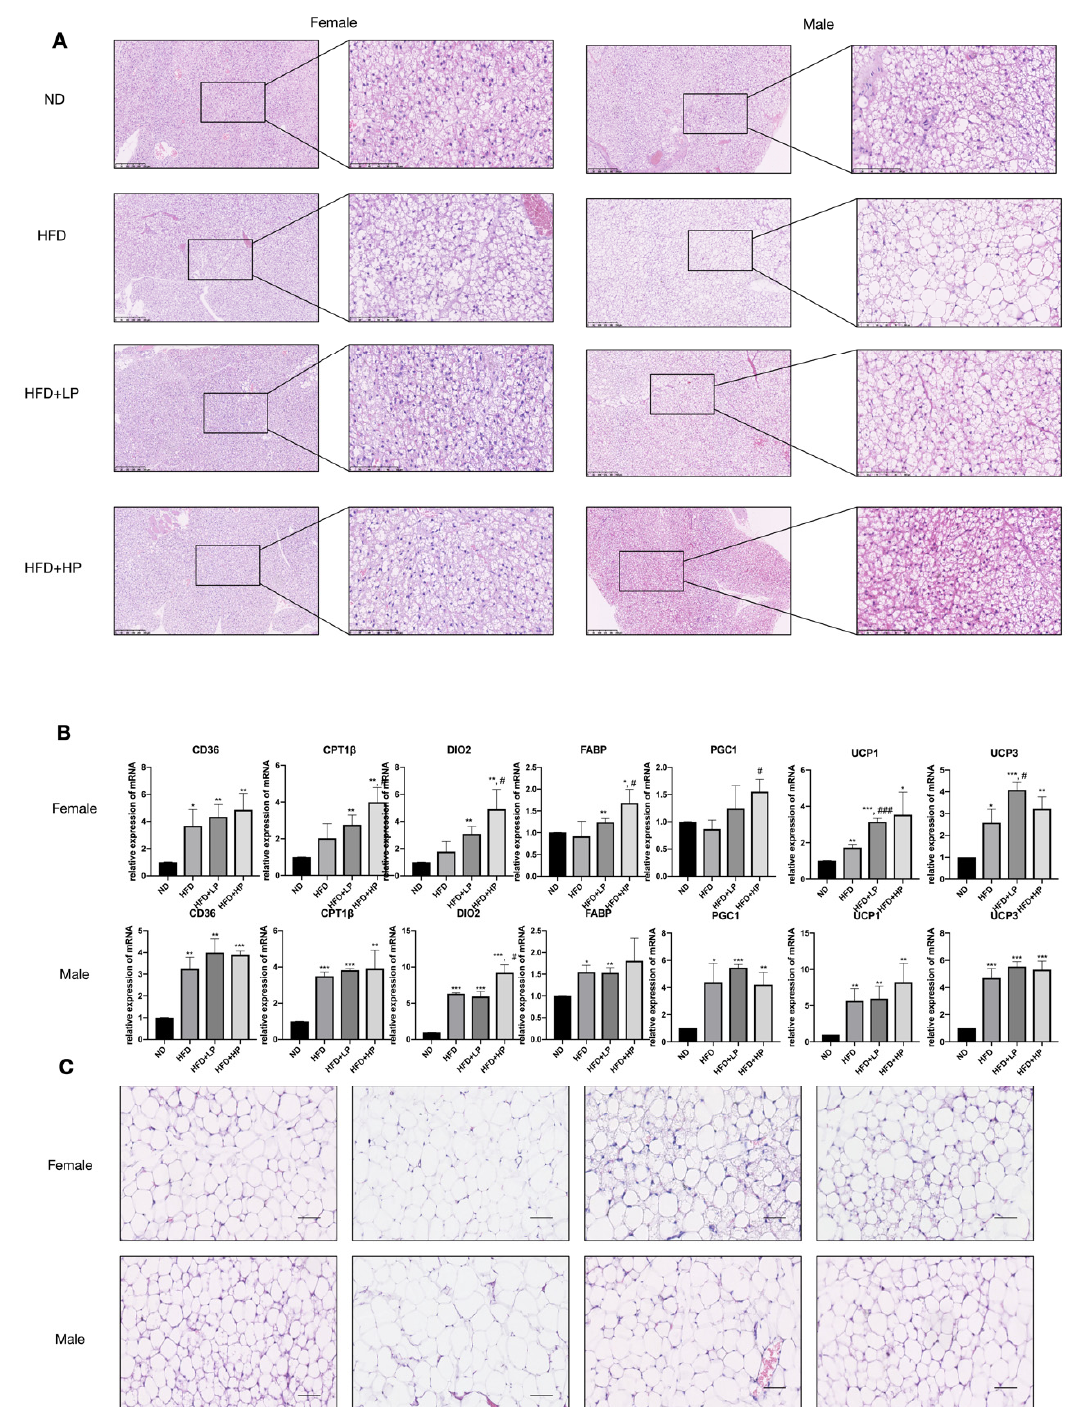
Figure 4. E ff ects of CP on adipose tissue (BAT & WAT) formation in HFD-fed mice. ( A ) Hematoxylin and eosin (H&E) staining of brown adipose tissue section. Each bar: 50 µ m in original photo; 20 µ m in Figure 4. Effects of CP on adipose tissue (BAT & WAT) formation in HFD-fed mice. (A) Hematoxylin enlarged photo. ( B ) The relative mRNA expression of adipose browning-related genes ( CD36, CPT1 β , and eosin (H&E) staining of brown adipose tissue section. Each bar: 50 μ m in original photo; 20 μ m DIO2, FABP, PGC1, UCP1, and UCP3 ) in BAT. ( C ) H&E staining of epididymal and parametrial white in enlarged photo. (B) The relative mRNA expression of adipose browning-related genes ( CD36, adipose tissue sections. Scale: 100 µ CPT1 β , DIO2, FABP, PGC1, UCP1, and UCP3 ) in BAT. (C) H&E staining of epididymal and parametrial white adipose tissue sections. Scale: 100 μ m.